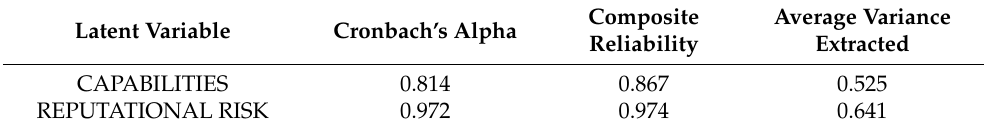
Table 1. AVE and Composite Reliability.